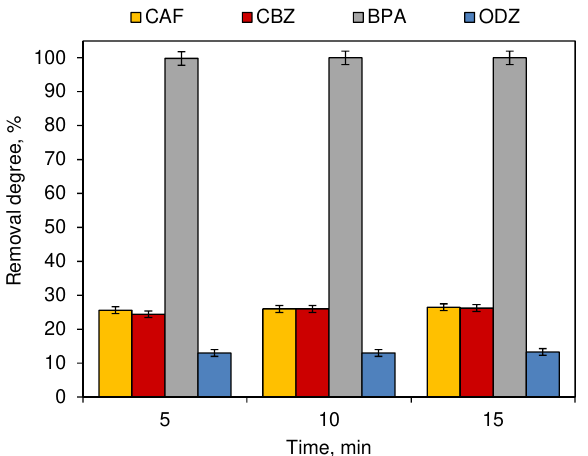
Figure 2. Influence of chlorination time on the removal degree of CECs (dark chamber experiment; n = 3; where CAF—caffeine, CBZ—carbamazepine, BPA—bisphenol A, ODZ—oxadiazon).